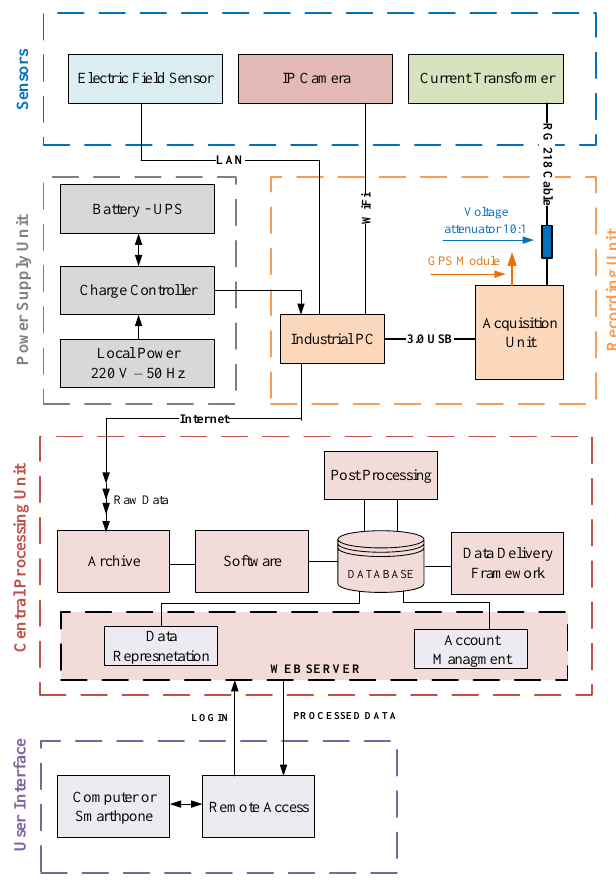
Figure 4. Block diagram of measuring